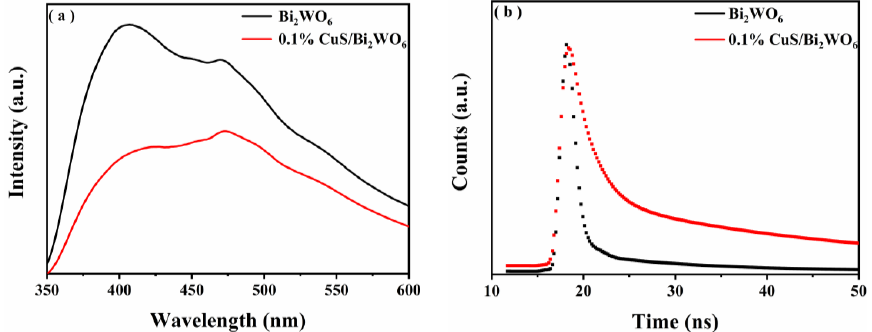
Figure 10. Photoluminescence (PL) spectra of Bi 2 WO 6 and 0.1% CuS/Bi 2 WO 6 heterostructure ( a ),